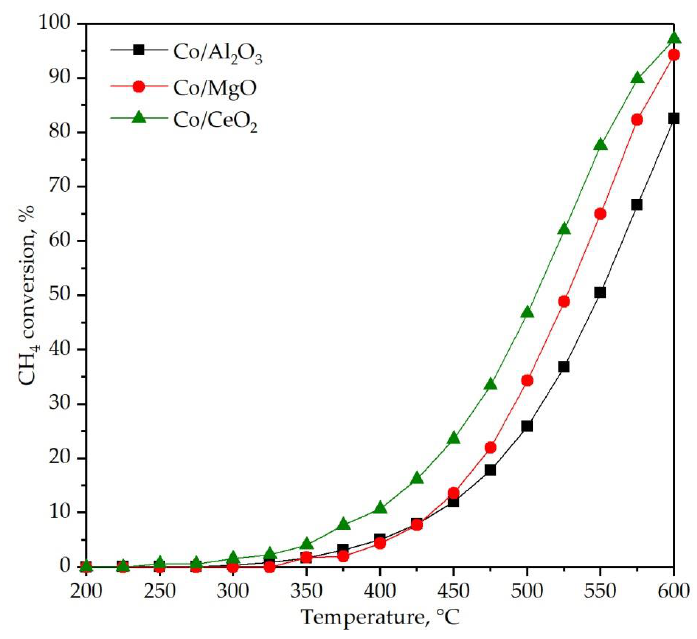
Figure 7. Light-o ff curves of the supported cobalt catalysts. Figure 7. Light-off curves of the supported cobalt catalysts. Table 3. Kinetic results of the oxidation of lean methane over the supported cobalt catalysts.